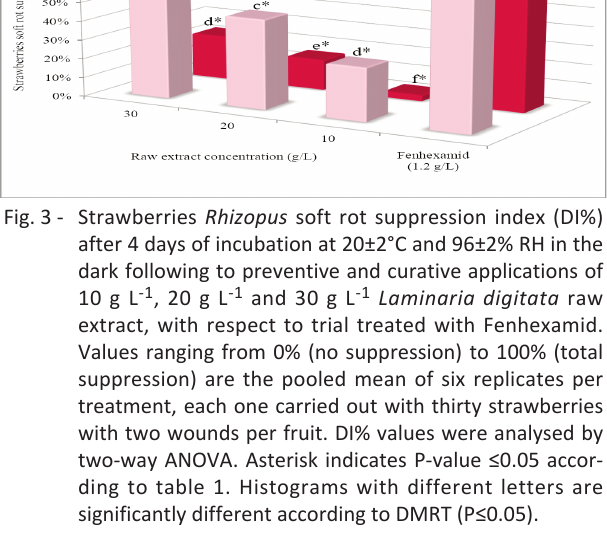
Fig. 4 - Rhizopus soft rot symp- tom on strawberries cv.